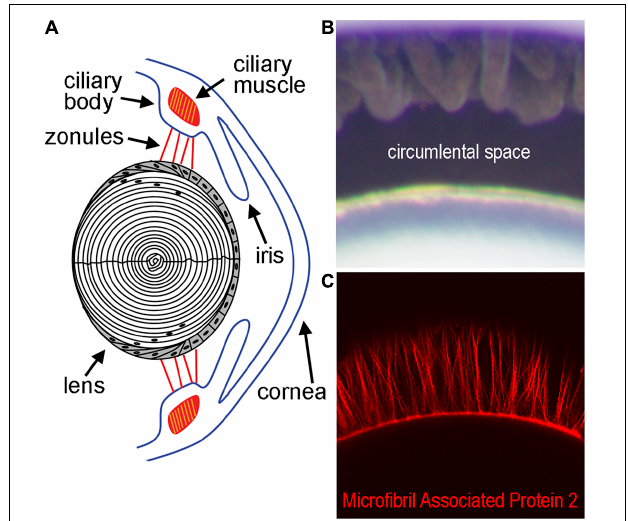
FIGURE 1 | Diagram of the lens and supporting structures. (A) The anterior surface of the lens rests directly behind the iris and is attached by the Zonules of Zinn to the ciliary body. The Zonules of Zinn transduce tension generated by the ciliary muscle to the lens equator during the process of accommodation. (B) The area between the lens and ciliary body containing the zonules in a mouse eye, also known as the circumlental space, as visualized by light microscopy. (C) Fluorescent labeling of the zonules using an antibody against Microfibril Associated Protein-2 visualized by confocal